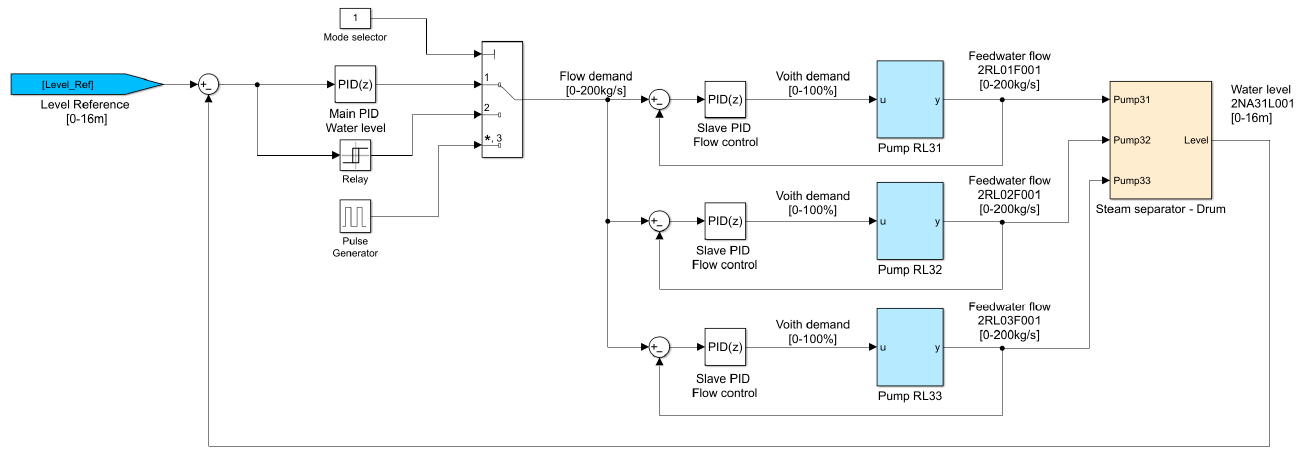
Figure 3. TE Kostolac B2 Unit, 350 MW nominal electric power—proposed PID cascade control design for level control of steam separator, with the operation mode selector: nominal mode—PID controller (mode 1), relay experiment (mode 2), wide pulse (mode 3).